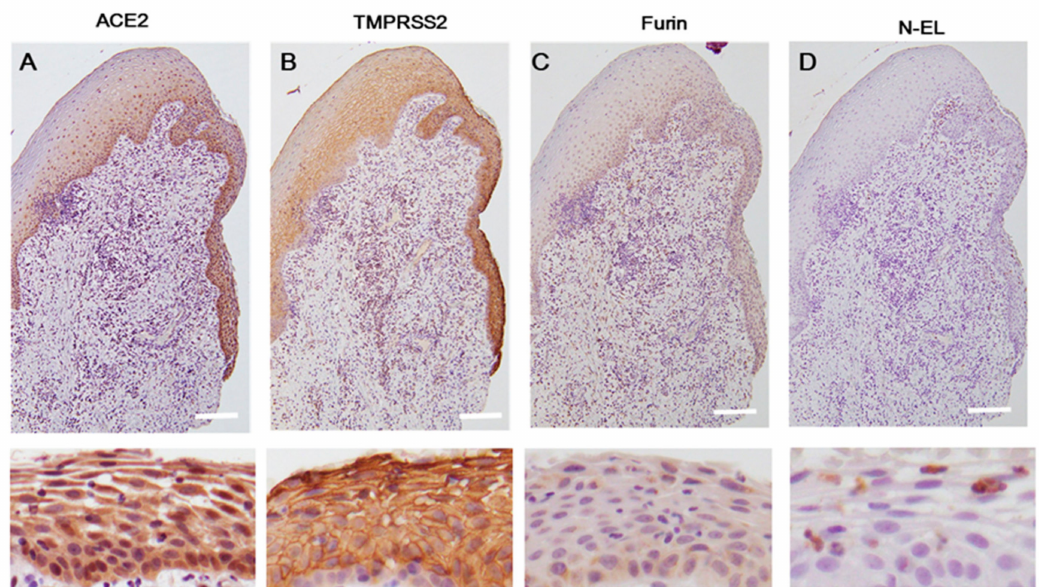
Figure 3. The gingival tissues, including the sulcus epithelium. Immunohistochemical expression of ACE2 ( A ), TMPRSS2 ( B ), and furin ( C ). No N-EL staining was detected in the gingival squamous epithelium ( D ). High magnification images showing ACE2, TMPRSS2, and furin-positive cells in the gingival squamous epithelium and an N-EL-positive signal in neutrophils. Scale bar = 100 µ m. ACE2, angiotensin-converting enzyme 2; TMPRSS2, transmembrane protease serine 2; N-EL, neutrophil-elastase. Table 1. Expression level of ACE2, TMPRSS2, and furin in the tongue and gingiva. Gingiva (n = 16) Tongue (n = 15) Expression